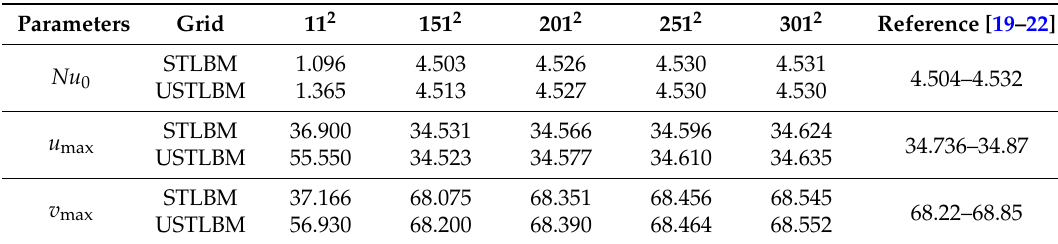
Table 1. Comparisons of flow parameters in Ra = 10 5 at different mesh sizes.